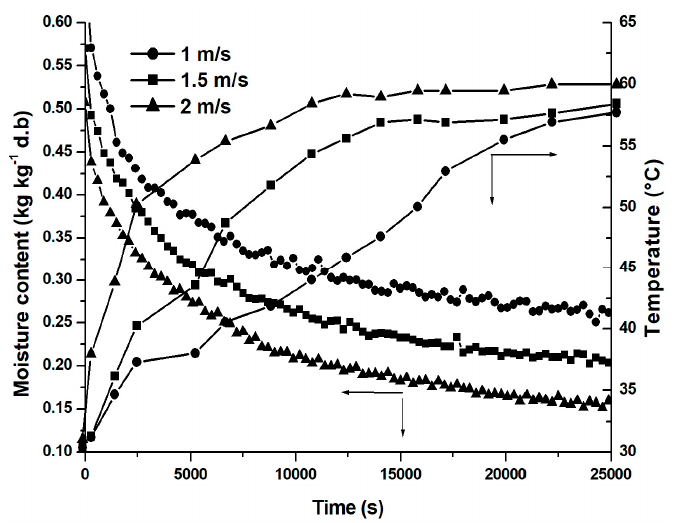
Figure 7. The effect of the air velocity on the evolution of moisture content and temperature of the thin layer of corn; T = 60 °C (dry air RH = 0%).